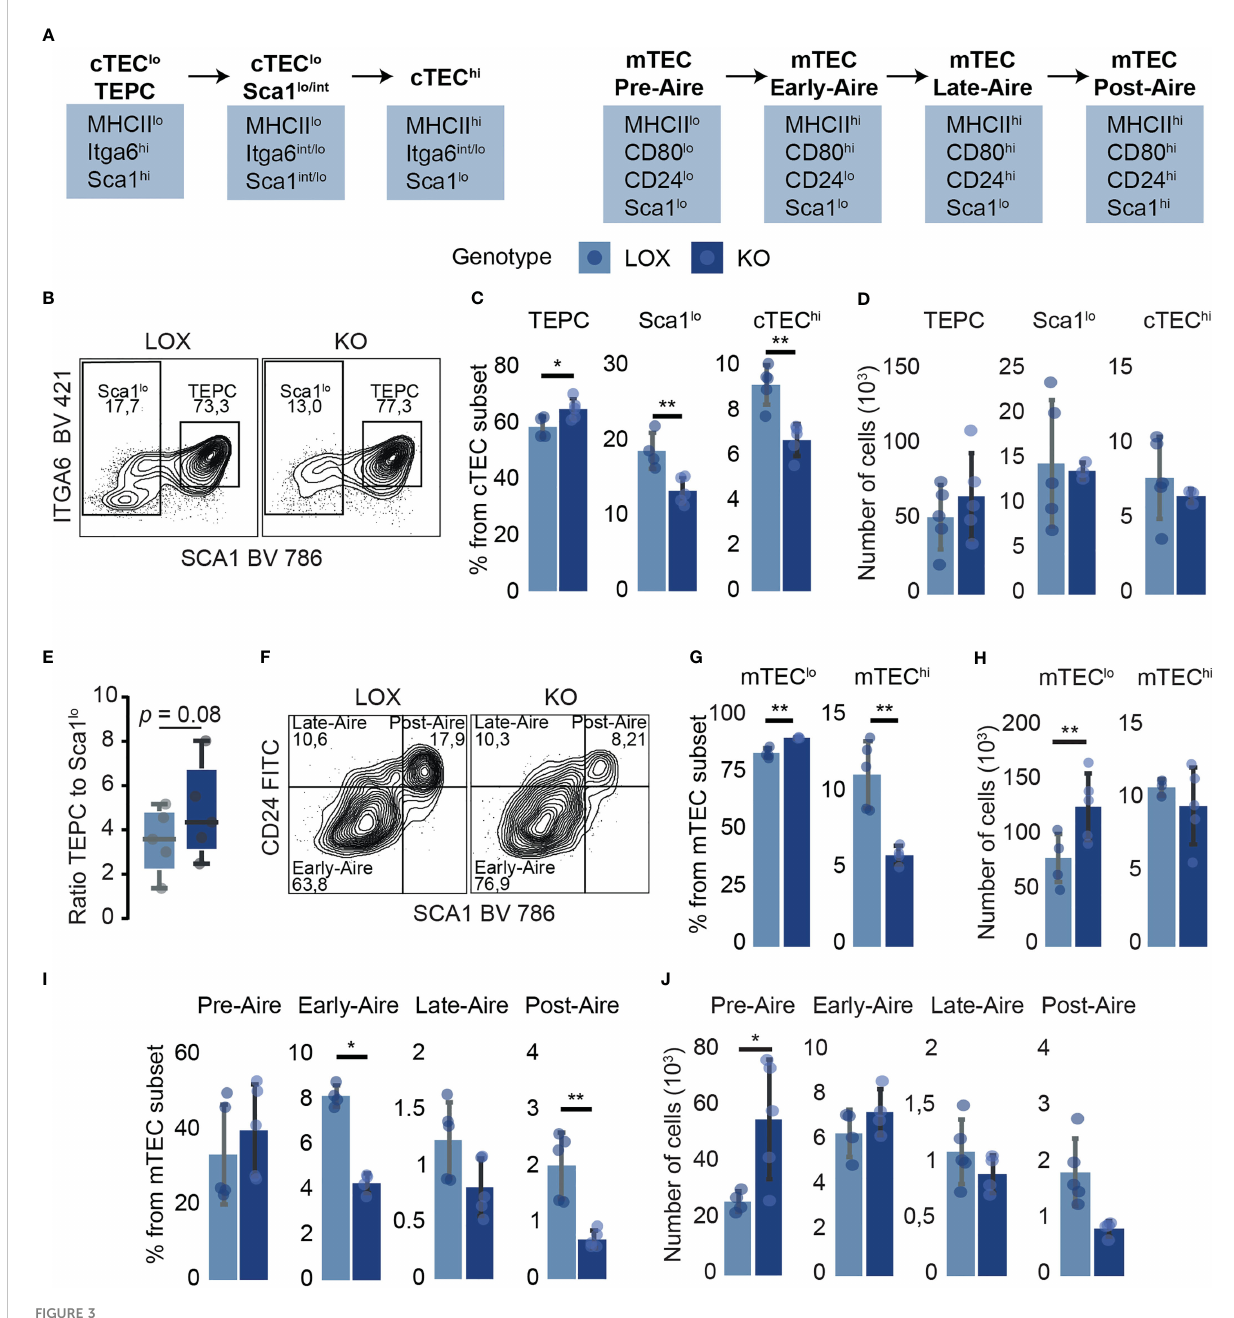
FIGURE 3 TEC subpopulation analysis suggests a role for Klf4 in maintaining TEC differentiation in homeostatic conditions. (A) Schematic model representing markers used for TEC subpopulation identi fi cation (41, 42). (B) Flow cytometry contour plots representing Sca1 lo and TEPC proportions in LOX and KO females. (C, D) Proportions (C) and absolute numbers (D) of cTEC subpopulations (from n=4-5 mice per genotype). (E) The ratio of TEPC to Sca1 lo absolute numbers in KO and LOX females (n=4-5). Results are expressed as the median and interquartile range (IQR). (F) Flow cytometry contour plots representing Early-, Late-, and Post-Aire proportions in LOX and KO females. (G, H) Proportions (G) and absolute numbers (H) of mTEC lo and mTEC hi in LOX and KO females. (I, J) Proportions (I) and absolute numbers (J) of mTEC subpopulations (n=4-5). All analyses were performed in thymi of 12 weeks aged non-pregnant females. TECs were tested in three independent experiments, respectively. LOX and KO genotypes are displayed in pale blue and dark blue, respectively. Signi fi cance was assessed using an unpaired two-tailed Student ’ s t -test. (* p <0.05 and ** p